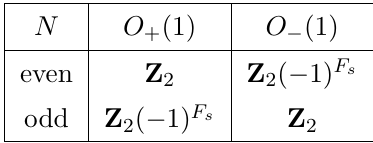
Table 3 . De(cid:12)nitions of O (cid:6) (1)